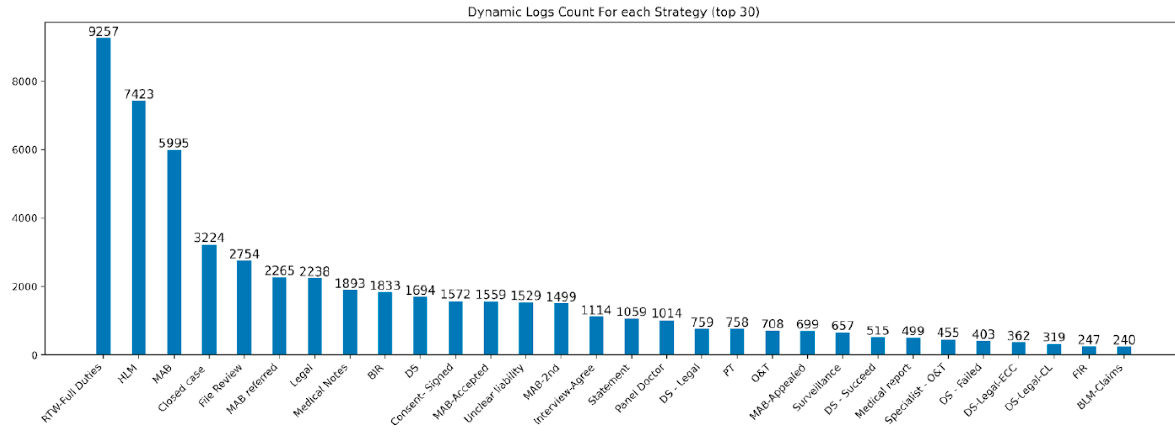
Figure 3. Dynamic logs count for each strategy.